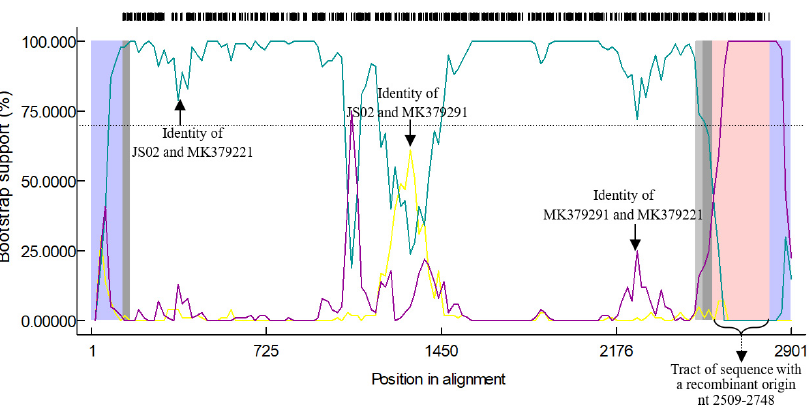
Figure 3. Recombination analysis of RVC/Pig/CHN/JS02/2018/G6P6 VP2 gene with other RVC